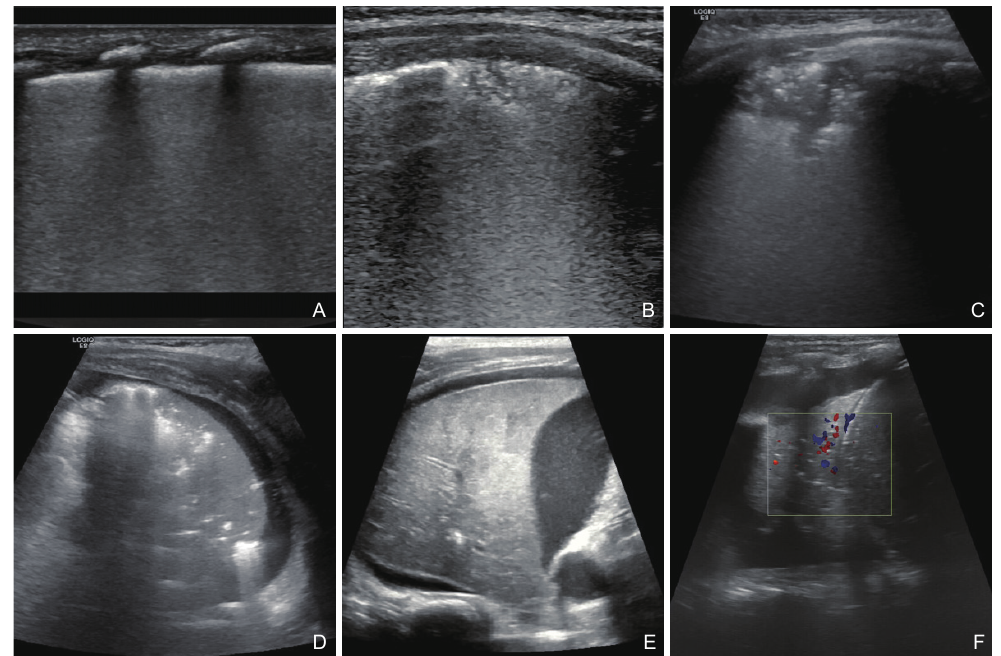
Figure 9 Pulmonary contusion and laceration sonograms. (A) Fusion B-line; (B ~ C) Patchy consolidation; (D) Massive consolidation with B-line of peripheral lung tissue; (E) Pulmonary consolidation with massive pleural effusion; (F) There was blood flow signal in CDFI.